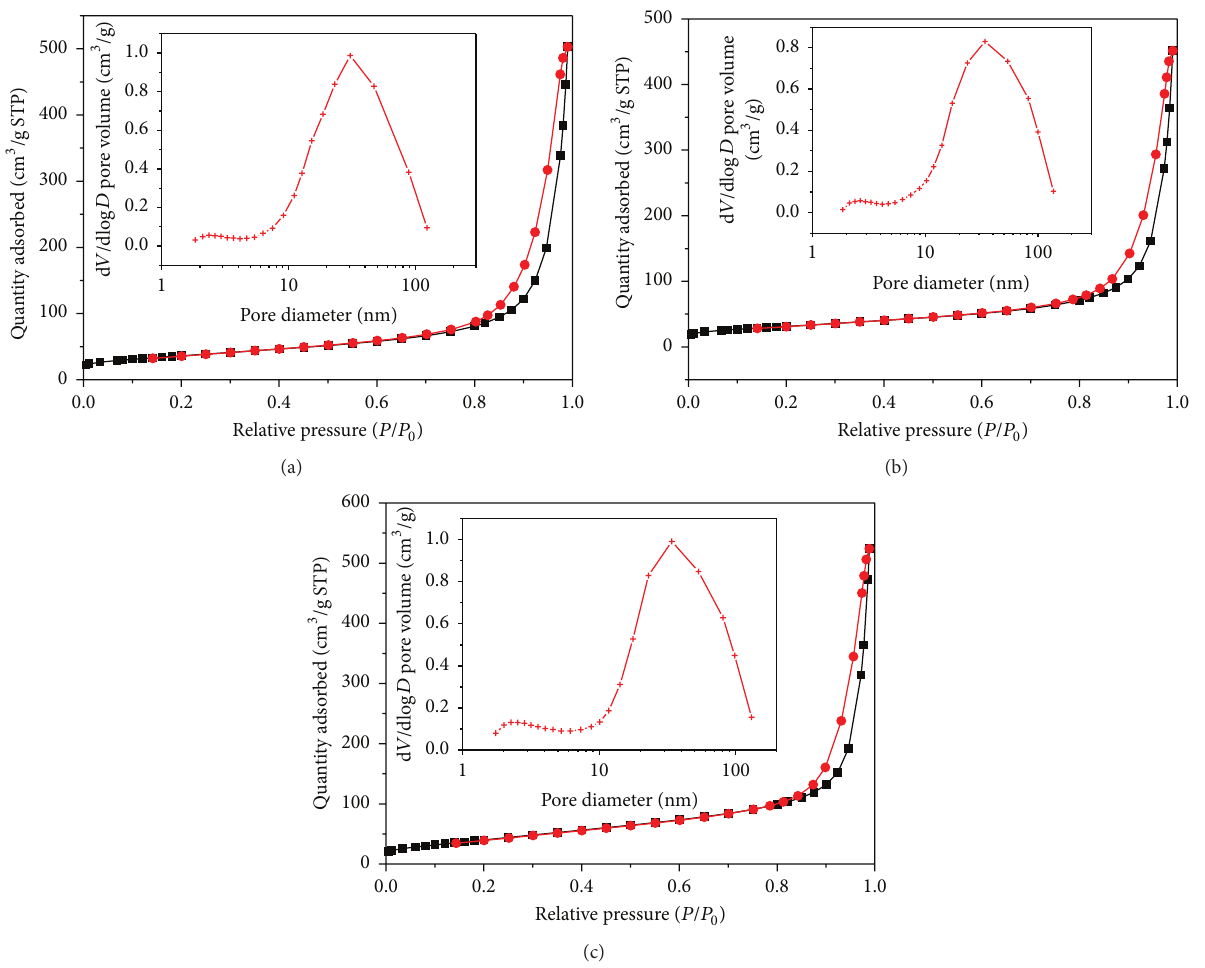
Figure4:N 2 adsorption-desorptionisothermcurvesandcorrespondingpore-sizedistributionof(a)asphericalTiO 2 aerogel-0.1 mLofTBOT, (b) aspherical TiO 2 aerogel-0.5 mL of TBOT, and (c) spherical TiO 2 aerogel-5.0 mL of